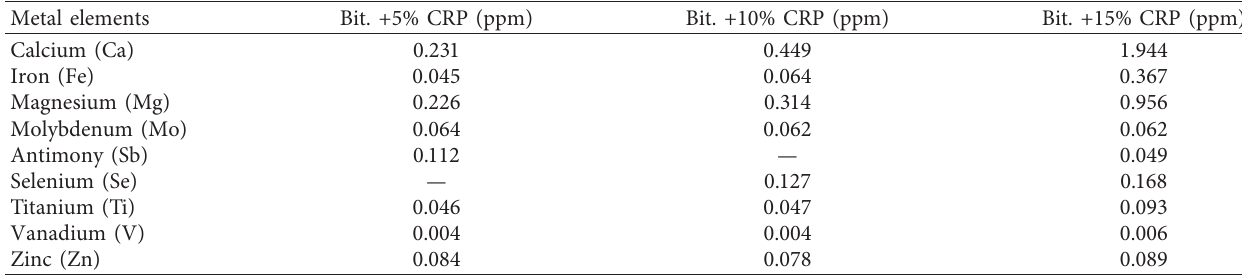
Table 9: Metal elements’ concentrations on TS-modified bitumen leachate